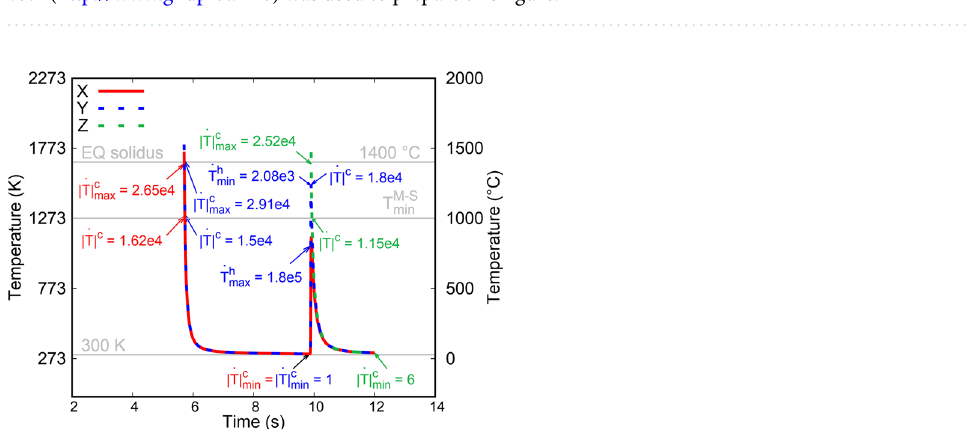
Figure 6. Comparison of equivalent diameters, also called size, of oxide precipitates (Oxides), non-oxide precipitates (Non-oxides), and the oxide (Mixed oxides) and non-oxide (Mixed non-oxides) inclusions in mixed precipitates in L1–L5. Equivalent diameter is the diameter of a circle whose area is equivalent to the corresponding area of the precipitate/inclusion in its HAADF image. Values in black font represent maximum and minimum equivalent diameters. Values in colored font represent average equivalent diameters, which are the diameters of a circle whose area is equivalent to the average of the areas of all precipitate/inclusions belonging to a category. The colored dashes represent the individual sizes of a precipitate/inclusion. Gnuplot v5.4 (http:// www. gnupl ot. info) was used to prepare this figure.